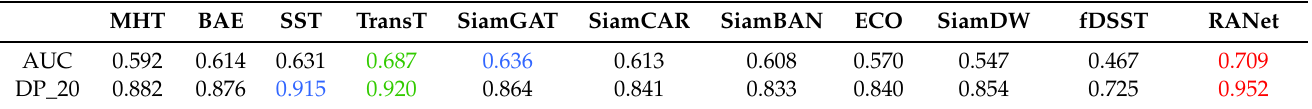
Table 3. AUC score and DP_20 value of 11 trackers on 35 sequences. The best three results are labeled in red, green, and blue,